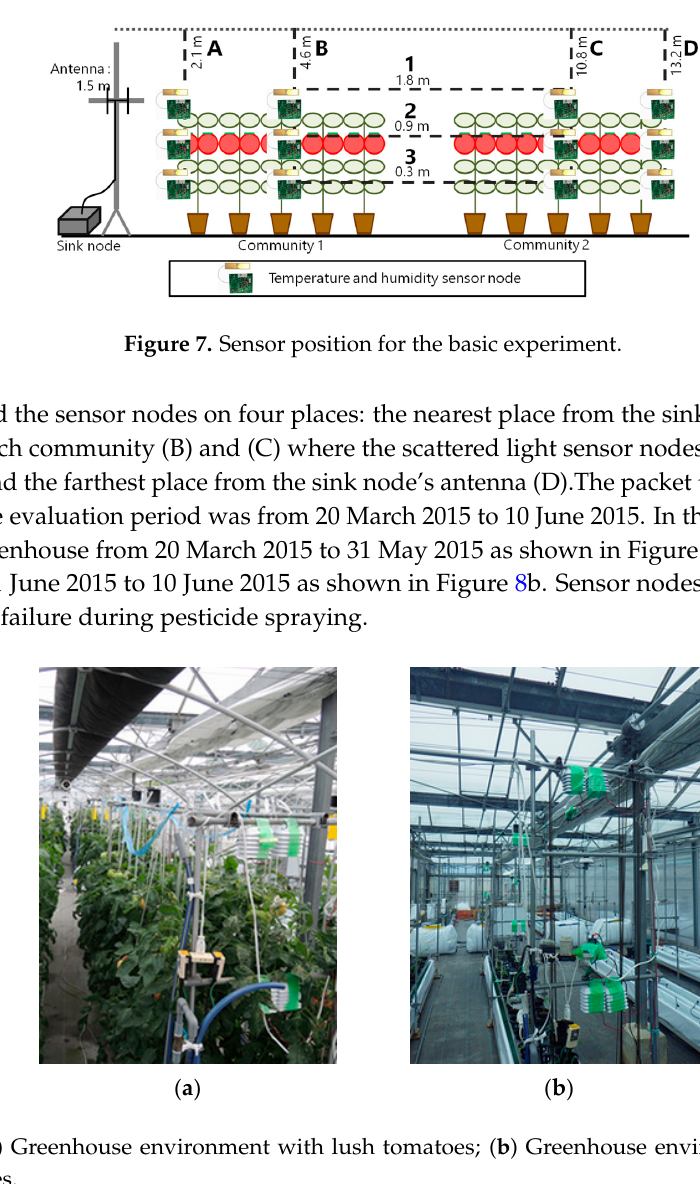
Figure 8. ( a ) Greenhouse environment with lush tomatoes; ( b ) Greenhouse environment without lush tomatoes.